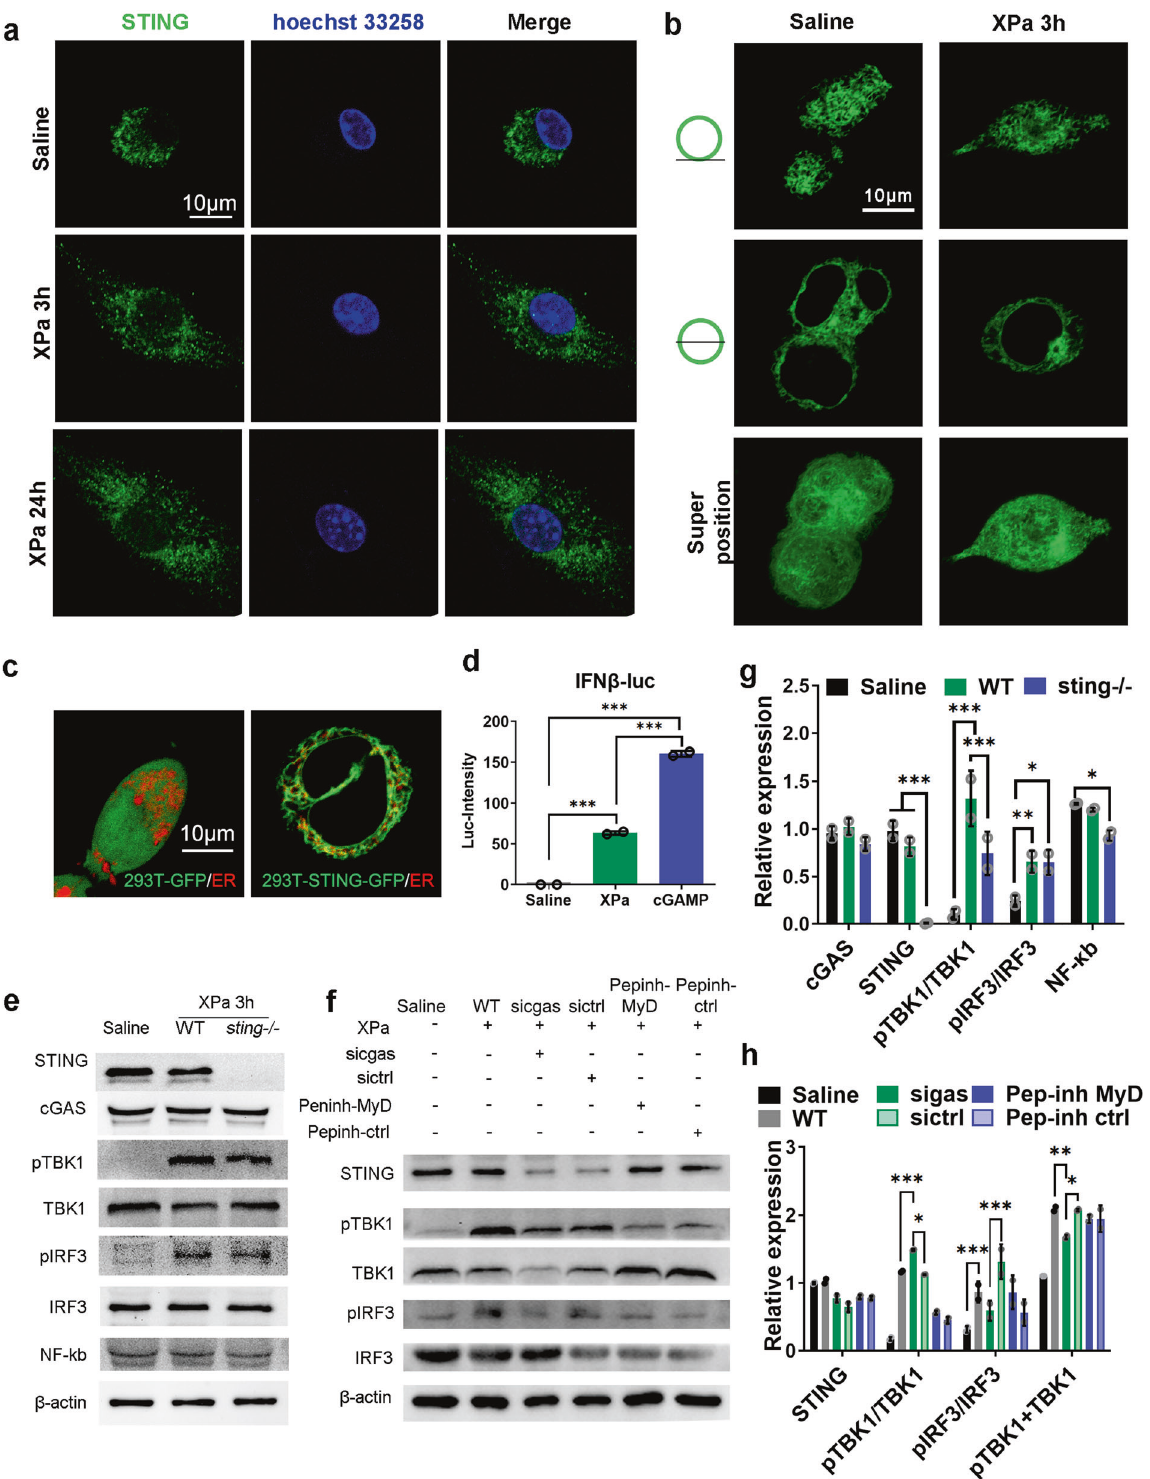
Fig. 3 XPa activated STING in BMDCs. a STING immuno fl uorescence staining of BMDCs stimulated with XPa for 3 h. b Lentivirus-infected 293 T cells stably expressing STING-GFP were treated with XPa for 3 h. c Lentivirus-infected 293 T cells stably expressing STING-GFP or GFP were stained with ER tracker (Invitrogen). The column graph shows the luciferase intensities of 293T-STING-GFP cells (transfected with IFN- β -promotor – luc plasmid) stimulated with XPa and the STING agonist — cGAMP (Sigma, sml1229). d Western blot analysis of related proteins in cGAS-STING pathway. e Western blot of BMDCs stimulated by XPa for 3 h after sicgas or MyD88 inhibitor (Pepinh-MyD) treatment. sictrl or Pepinh-ctrl as controls in the experiment. f Grayscale analysis of the western blot bands of d , n = 2. g Grayscale analysis of the western blot bands of e . Data were analyzed using two-way ANOVA test. * P < 0.05, ** P < 0.01, *** P < 0.001. No letter is present if no signi fi cant difference was observed